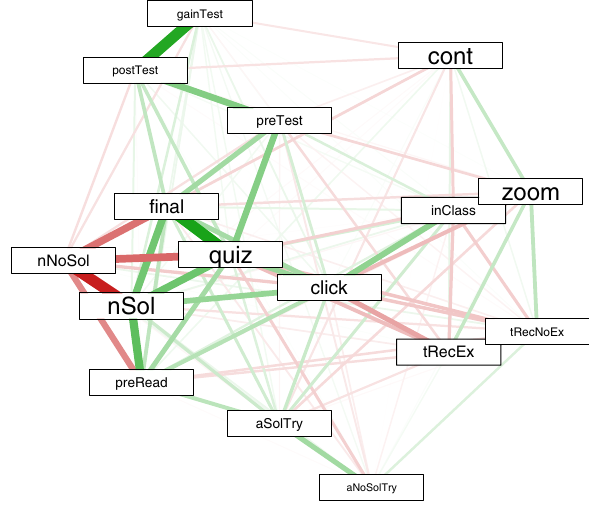
FIG. 2. Force-directed graph of the correlations Table II. Green edges represent positive correlations, red edges negative corre- lations, and the saturation and width denote